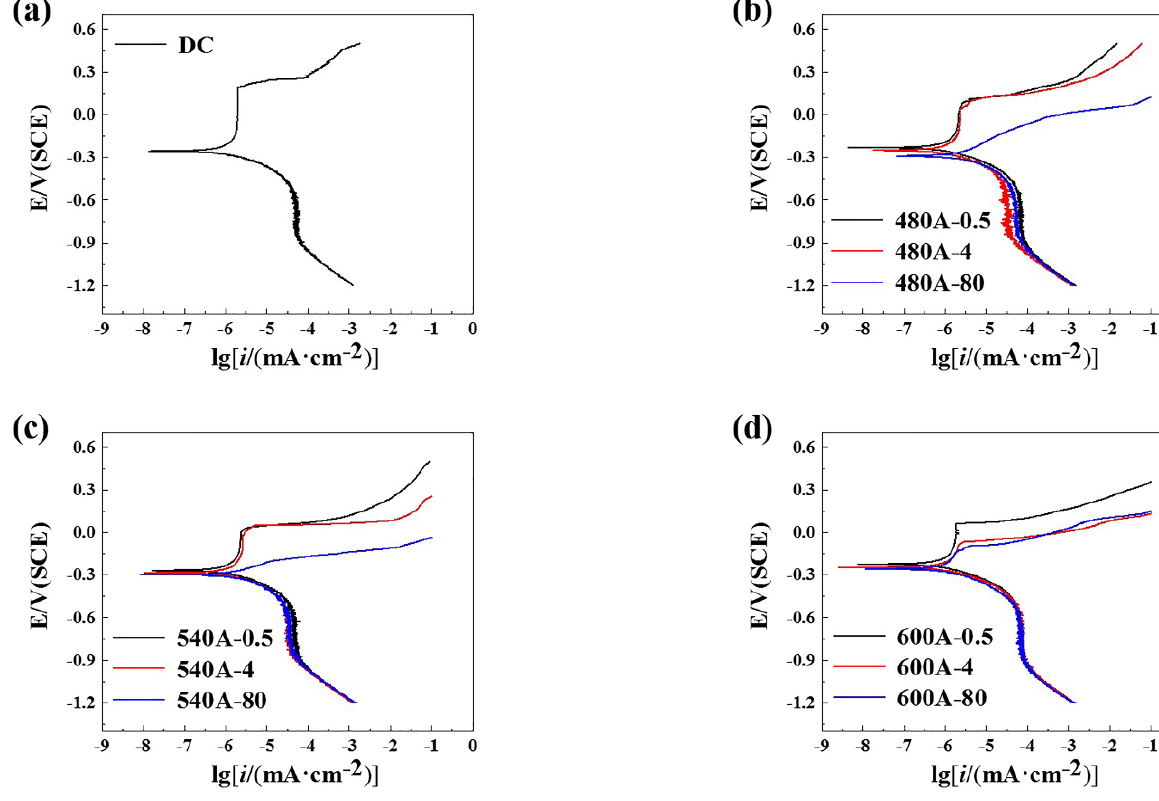
Figure 6. Potentiodynamic polarization curves of samples under various thermal conditions: ( a ) DC, ( b ) 480A-0.5/480A-4/480A-80, ( c ) 540A-0.5/540A-4/540A-80, and ( d ) 600A-0.5/600A-4/600A-80.